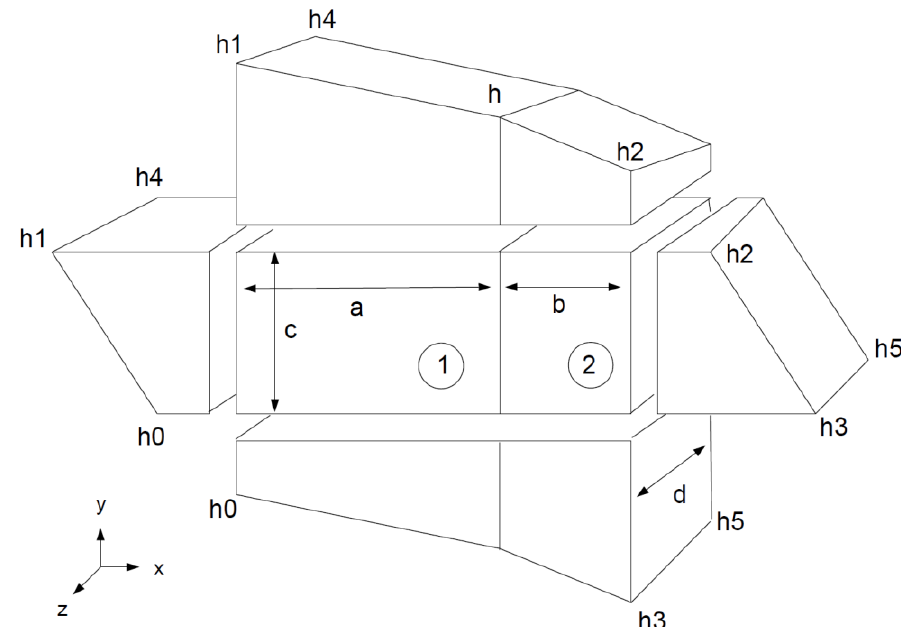
Figure 12. Composite medium made of two rectangular cuboid blocks. Definition of the geometry and of the boundary conditions.